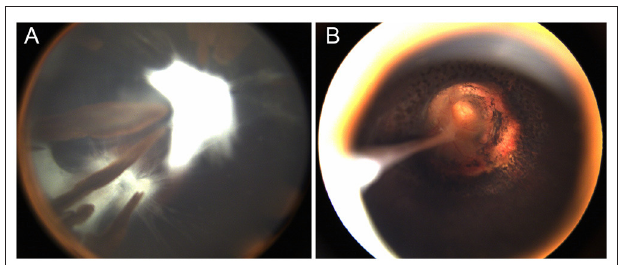
FIGURE 3 | One patient with morning glory disc anomaly associated with combined persistent fetal vasculature (PFV). (A) The classic PFV with a prolonged ciliary process; (B) The MGDA excavated optic disc and residual cord rising from the disc to the posterior of the capsule after lensectomy and laser coagulation around the optic